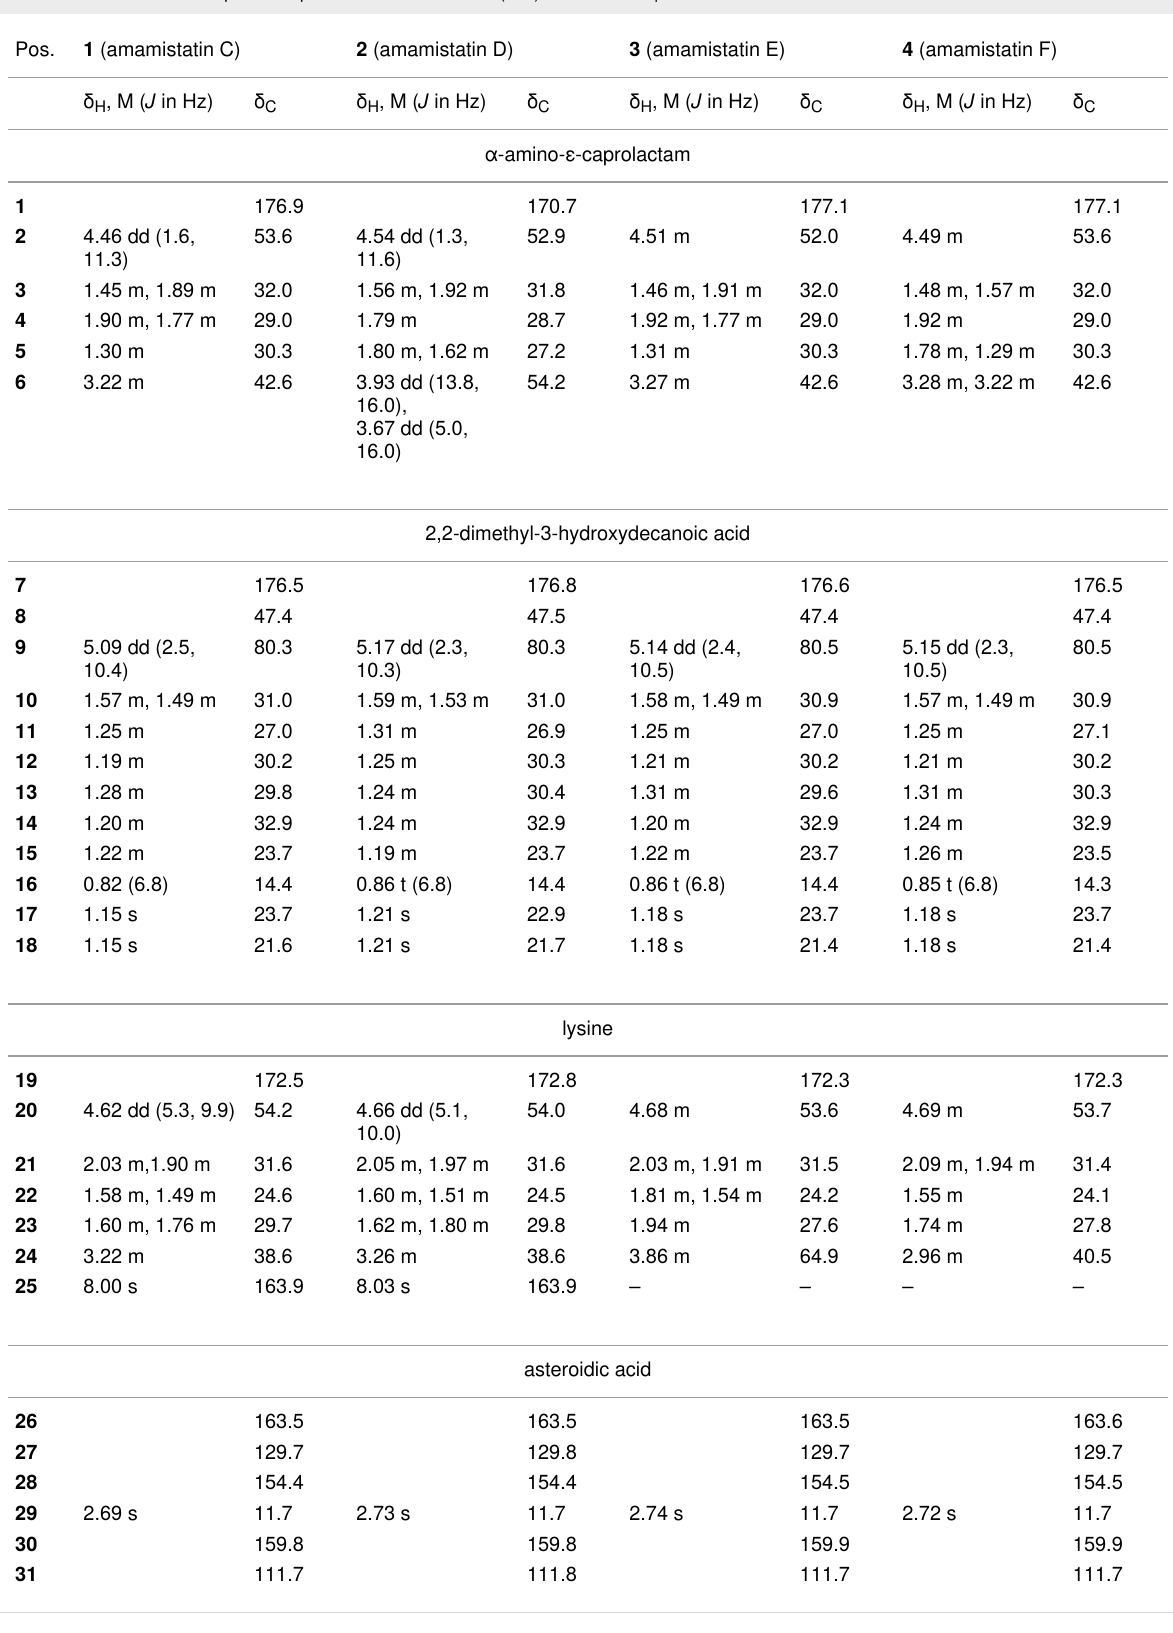
Table 1: 1 H and 13 C NMR spectroscopic data for amamistatins ( 1 – 4 ) in methanol- d 4 .